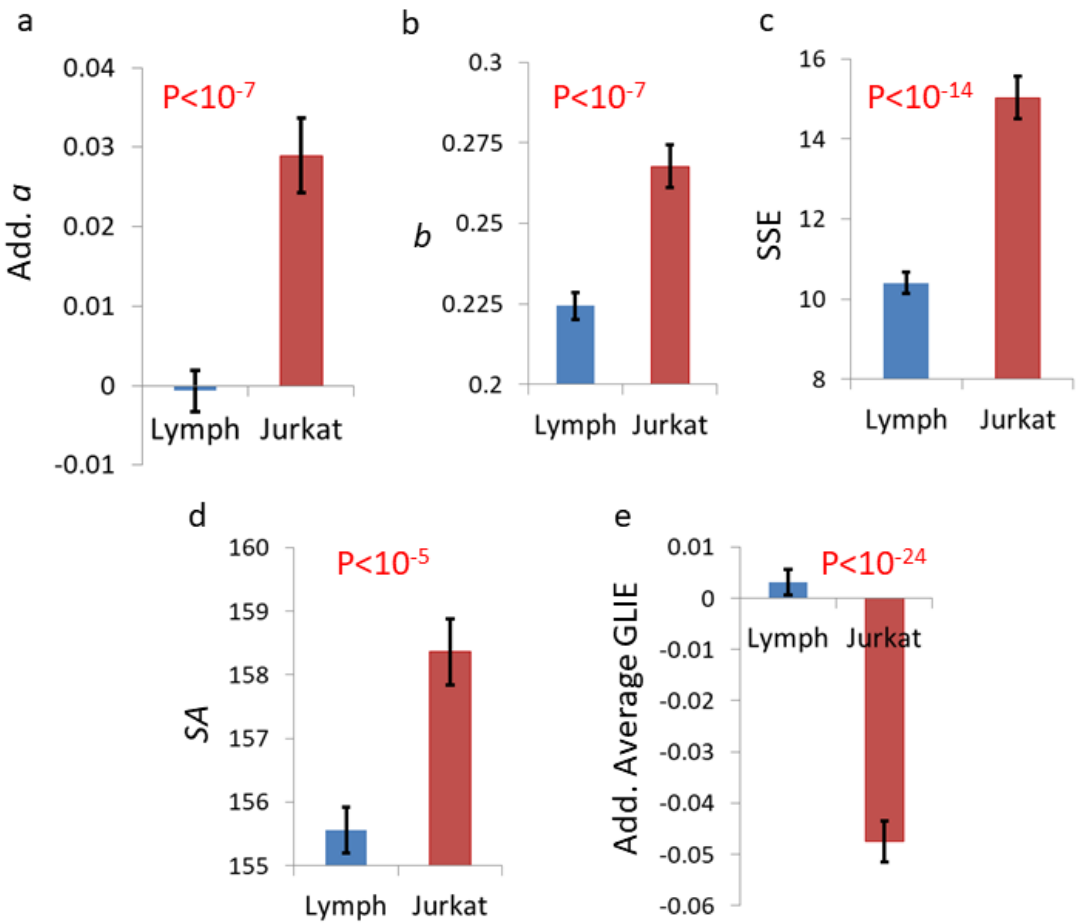
Figure 12. GLIE fluctuation parameters values in primary T cells (n = 219), in comparison to Jurkat cells (n = 161). parameter adj. a values ( a ) or parameter b values ( b ) or parameter SSE values ( c ) or parameter SA values ( d ) or parameter adj. GLIE values ( e ) in primary T cells vs. Jurkat cells. Error bars in panels a – e are SEM, and p -values are presented in the corresponding panels.